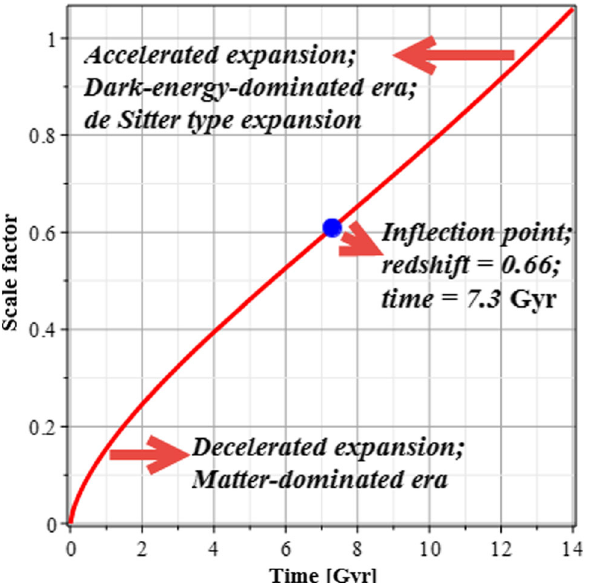
Fig. 2 This figure shows the behavior of the scale factor (32). As is observedthepresentvalueofitisoneandtheageoftheuniverseisabout 13 . 8Gyr. The onset of acceleration has happened at redshift z ∼ 0 . 66